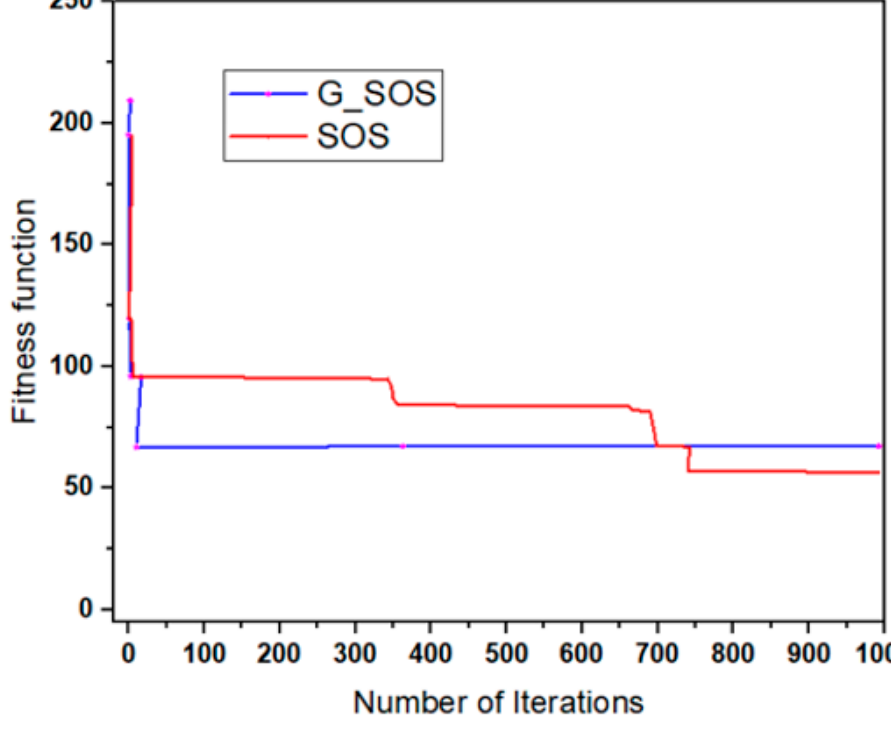
Figure 5. Degree of Imbalance comparison between G_SOS, SOS and PSO.